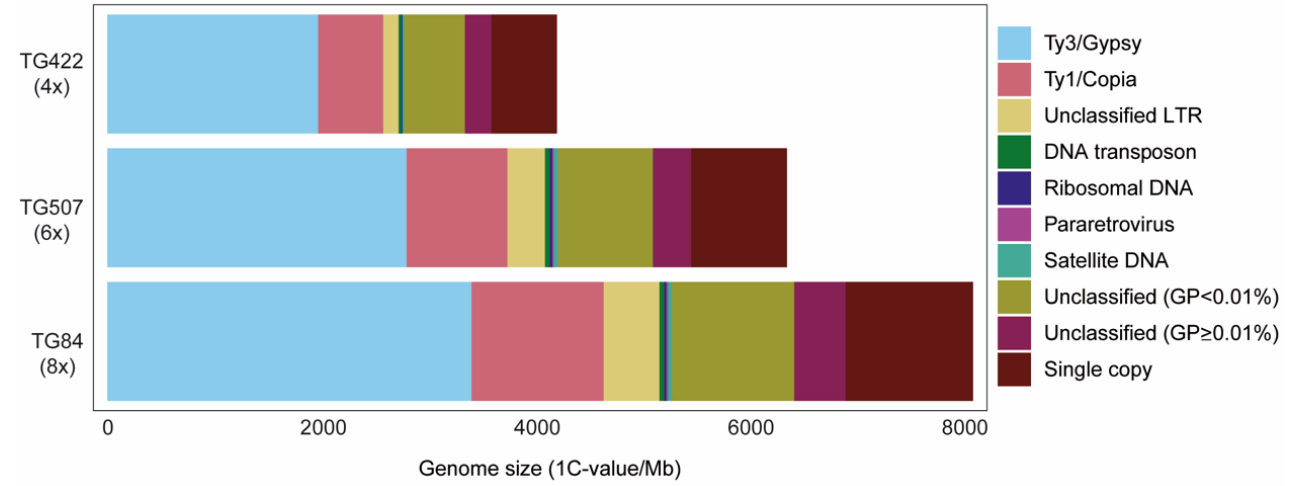
Figure 3. Genomic composition of Senecio doronicum representative of each cytotype (4x, 6x and 8x). Estimates of the genomic abundances (in Mb/1C) of different repeats are indicated and colored by repeat class [GP = Genome proportion (%), LTR = Long Terminal Repeat]. Table 1. Repetitive DNA composition estimated in individuals TG422 (4x), TG507 (6x) and TG84 (8x) as illustrative of the overall dynamics reported across cytotypes.